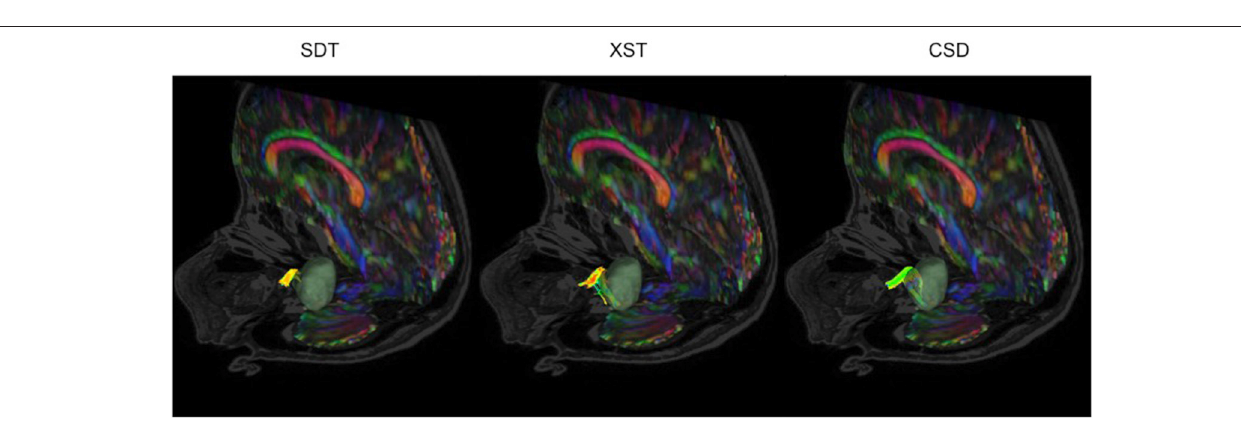
FIGURE 7 | CN VII/VIII generation from all three reconstruction methods in a patient with a vestibular schwannoma compressing CN VII/VIII-P06. SDT was only able to show portions of CN VII/VIII anterior to the tumor, where both XST and CSD-based tractography could show CN VII/VIII curving under the vestibular schwannoma. Single Diffusion Tensor Tractography (SDT), EXtended Streamline tractography (XST), Streamline tractography on fiber orientation distributions (FODs) derived from constrained spherical deconvolution (CSD). Fibers are displayed from a posterior-lateral perspective toward the brainstem. Images are displayed on a mixed anatomical-tensor model. The mixed anatomical-diffusion tensor model represents the tensor map being overlaid on a T1 anatomical